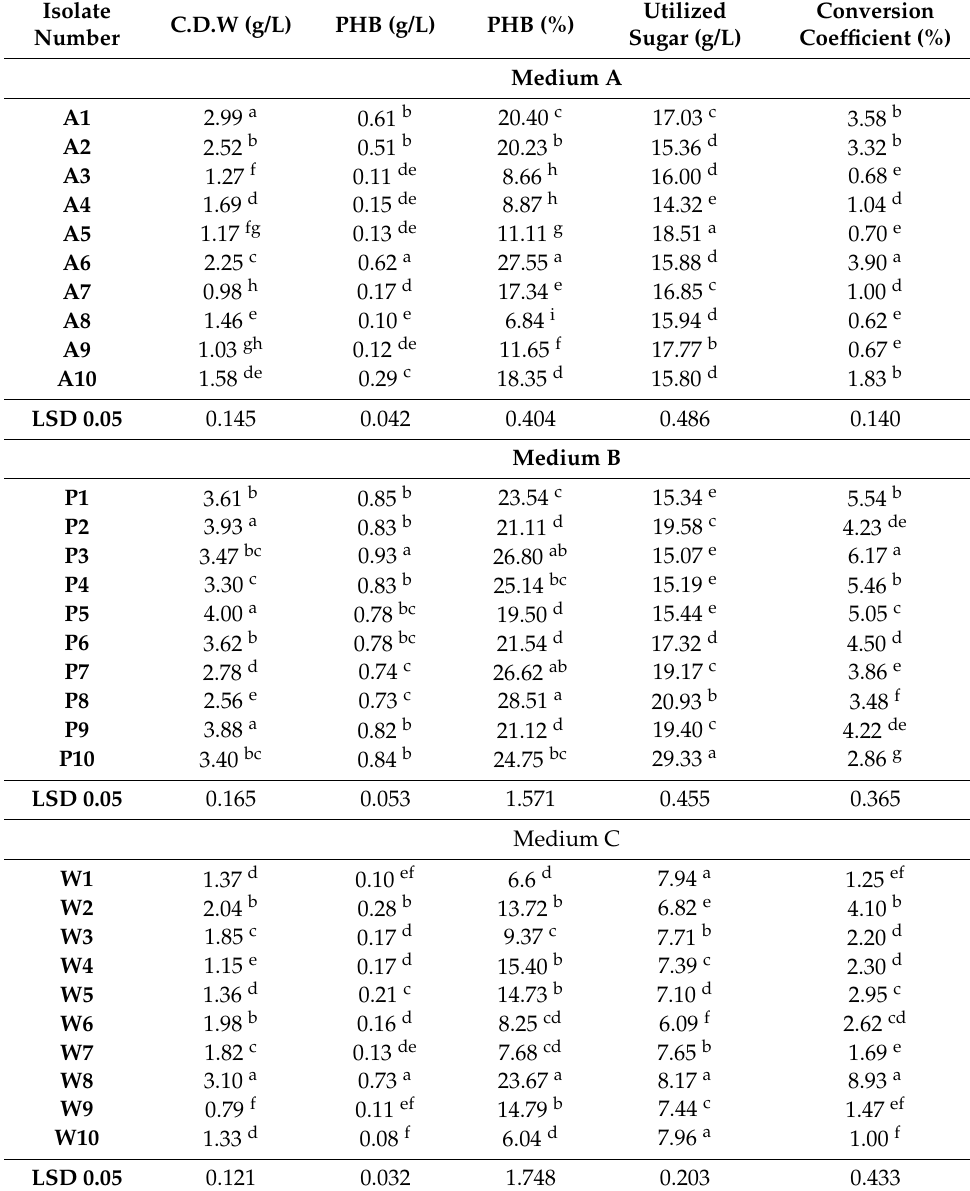
Table 1. Screening of different bacterial isolates to produce PHB on different media.